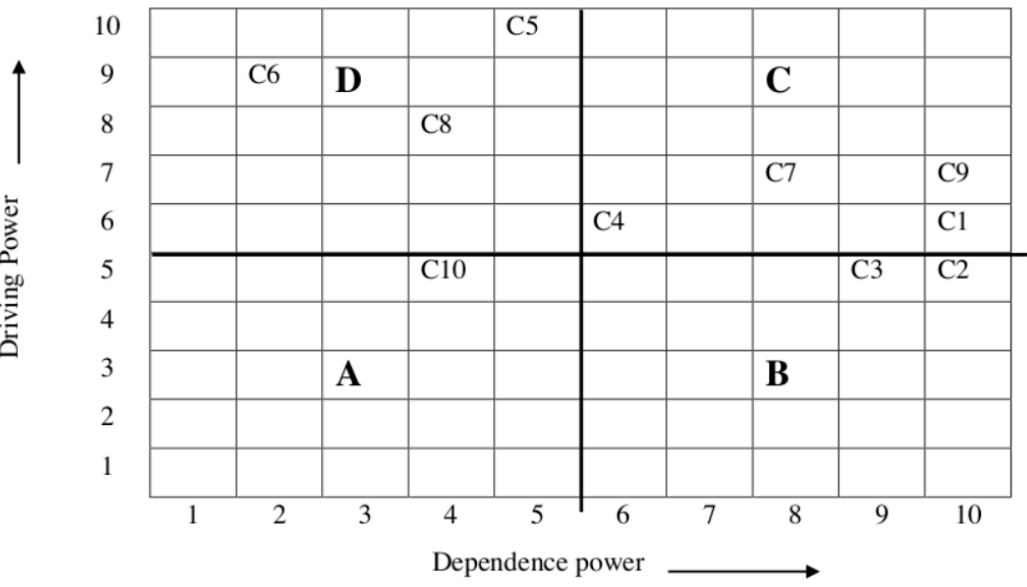
Figure 3. Grouping of I4.0 challenges.